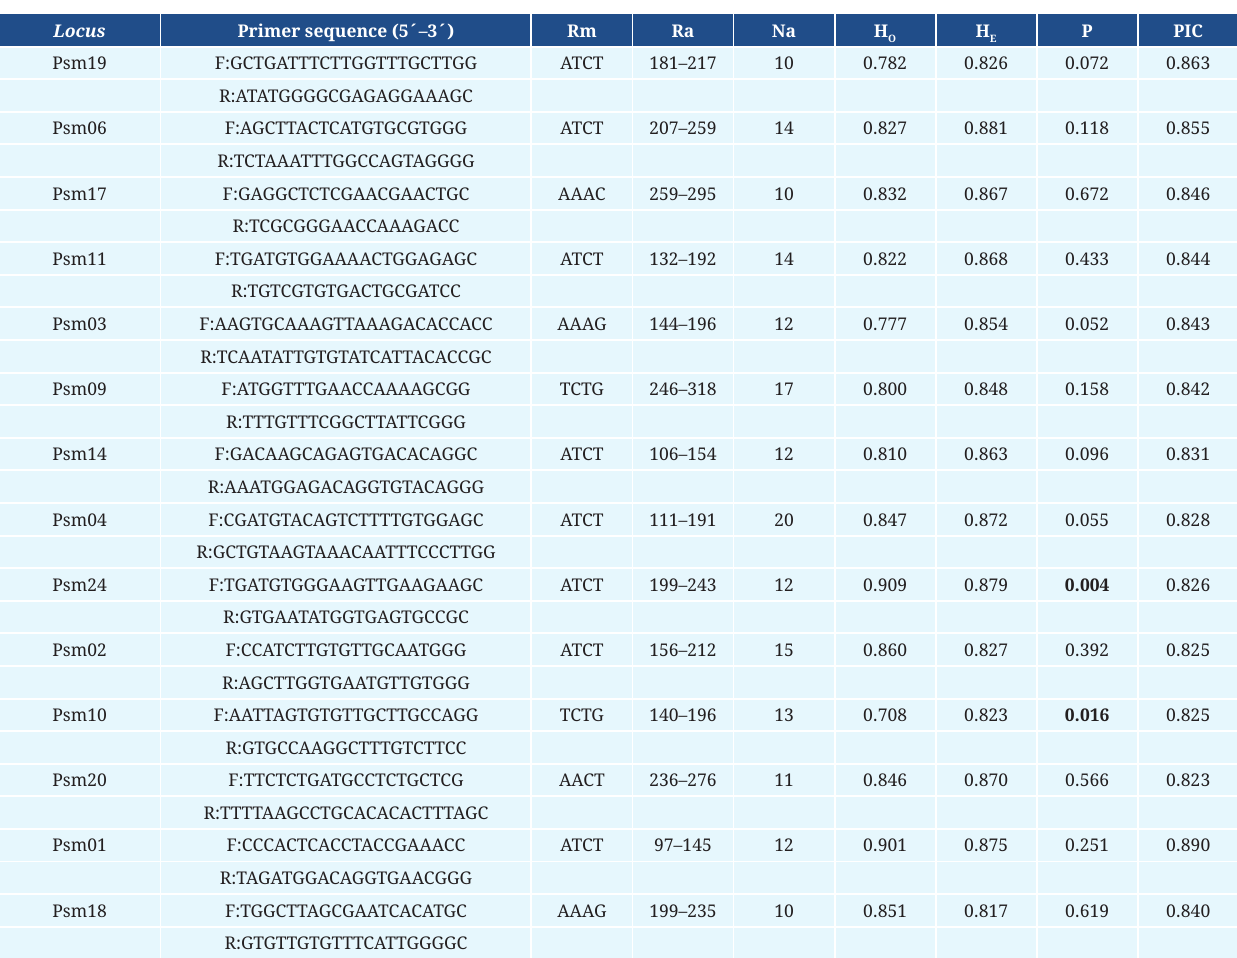
TABLE 1 | Characteristics of 25 microsatellite loci developed for Pseudoplatystoma magdaleniatum . F: forward; R: reverse; a–d: tails A–D (Blacket et al. , 2012); Rm: repeat motif; Ra: Allelic size range (bp); Na: number of alleles; H heterozygosity; P: p-value for Hardy-Weinberg equilibrium test (values in bold denote statistical significance at P < 0.05); PIC: Polymorphic Information